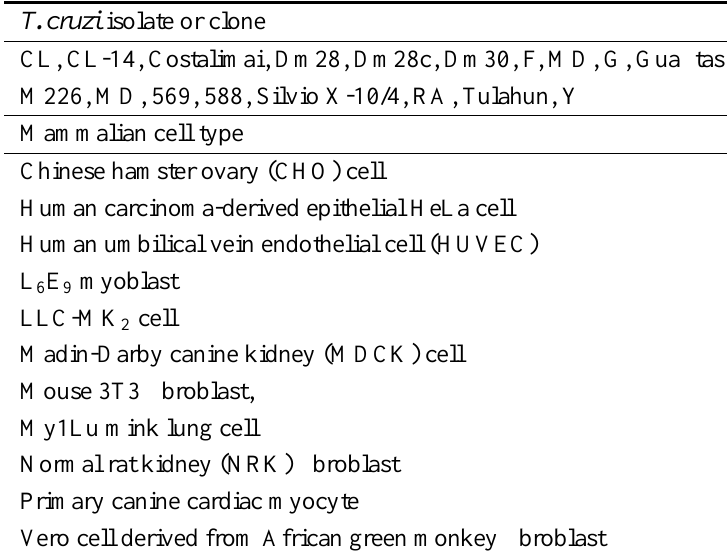
Mammalian cells and T. cruzi isolates used in invasion